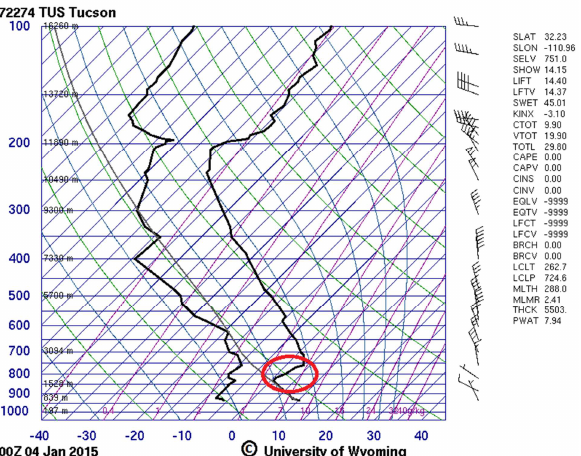
Figure 1. A Skew-T Log-P diagram of the radiosonde profile at Tucson AZ on Jan 4 2015, 00 UTC. The temperature profile (right) is clearly separated from the dew point curve (left). The x axis is the temperature in °C and skewed by an angle of 45° as indicated by the straight blue lines in the grid in order to make the plot more compact. The inverse logarithmic y axis is the air pressure in mbar, corresponding to an approximately linear height over ground scale as indicated at the horizontal grid lines. The water column (PWAT) was 7.94 mm = 0.794 g/cm 2 . The temperature profile is showing an inversion (rising temperature with increasing altitude, indicated by a red ellipse) between 1500 m and 2000 m. This stable zone is separating a calm ground layer from a turbulent upper layer (cf. the feathered arrows on the right side).